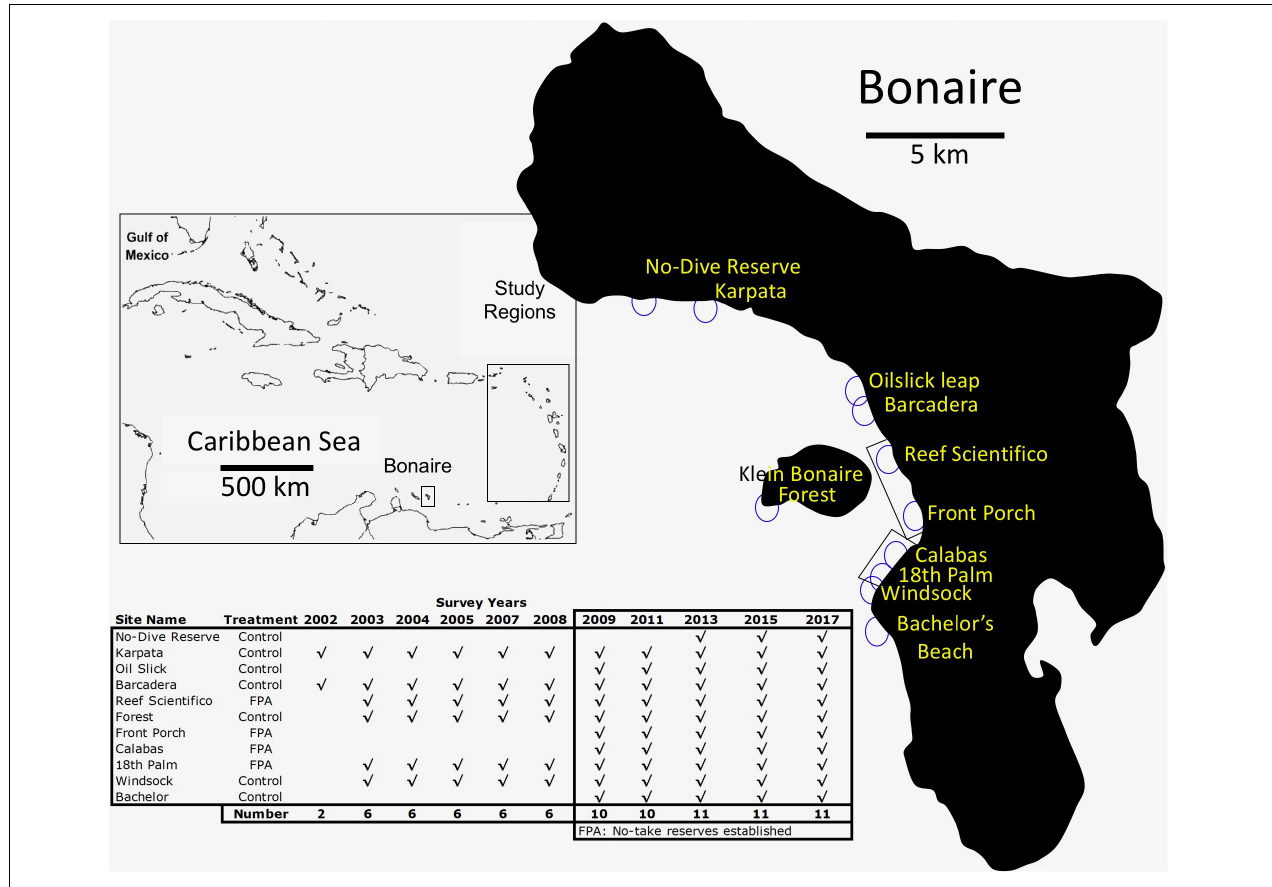
FIGURE 1 | Bonaire, Dutch Caribbean. Inset rectangle shows the island location and the Eastern Caribbean sites from Steneck et al. (2018) used for comparison. Circles on the island map show the location of 10 m depth monitoring stations. Inset table shows duration and frequency of monitoring at those stations. Coastally located rectangles show the location of no-take reserves (called “Fish Protection Areas,” or FPAs) that were established in 2008.